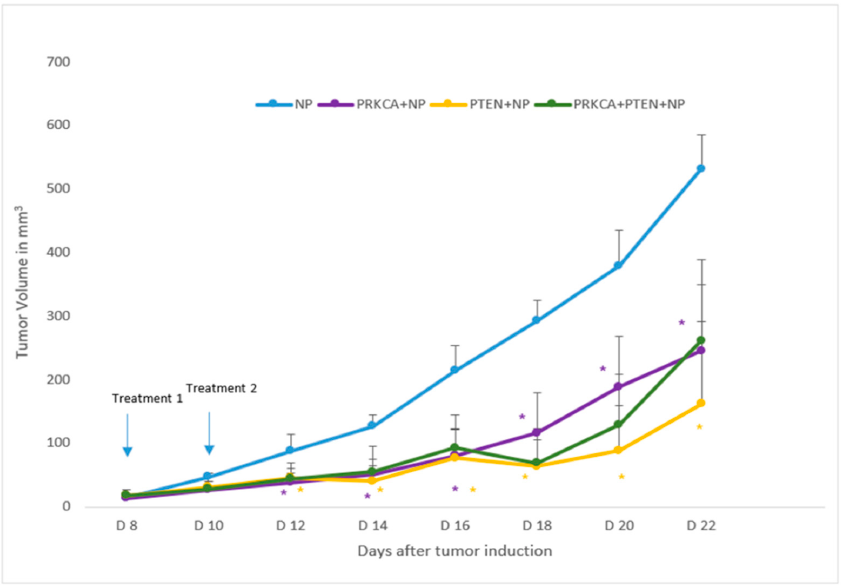
Figure 6. Tumor regression study following intravenous delivery of NPs, PRKCA siRNA+NPs, PTEN+NPs and PRKCA siRNA+PTEN+NPs in MCF-7-induced xenograft breast tumour model. MCF-7 cells were inoculated subcutaneously on